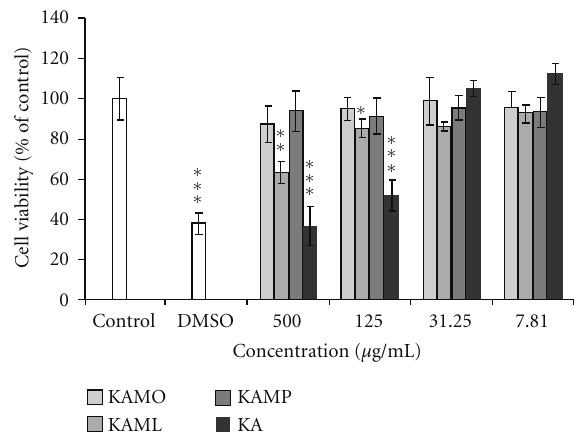
Figure 2: The e ff ects of KAMO, KAML, KAMP, and KA on the via- bility of B16F1 melanoma cells. DMSO (5%) was used as a negative control. Cells were treated with various doses of KAMO, KAML, KAMP, and KA (7.81–500 μ g/mL) for a total of 72 h incubation and were examined by MTT assay. Denotes ∗ P < 0 . 05, ∗∗ P < 0 . 01, ∗∗∗ P < 0 . 001 compared to untreated control. Data are presented as means ± S.E.M and expressed as % of control, n ≥ 3.